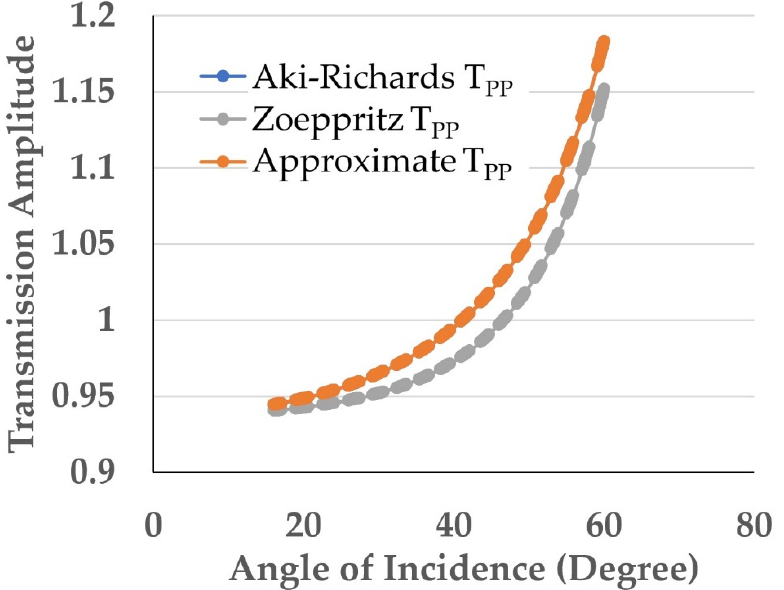
Figure 7. Fitting angle–amplitude (T PP ) data of CTP 88 in the oil reservoir.